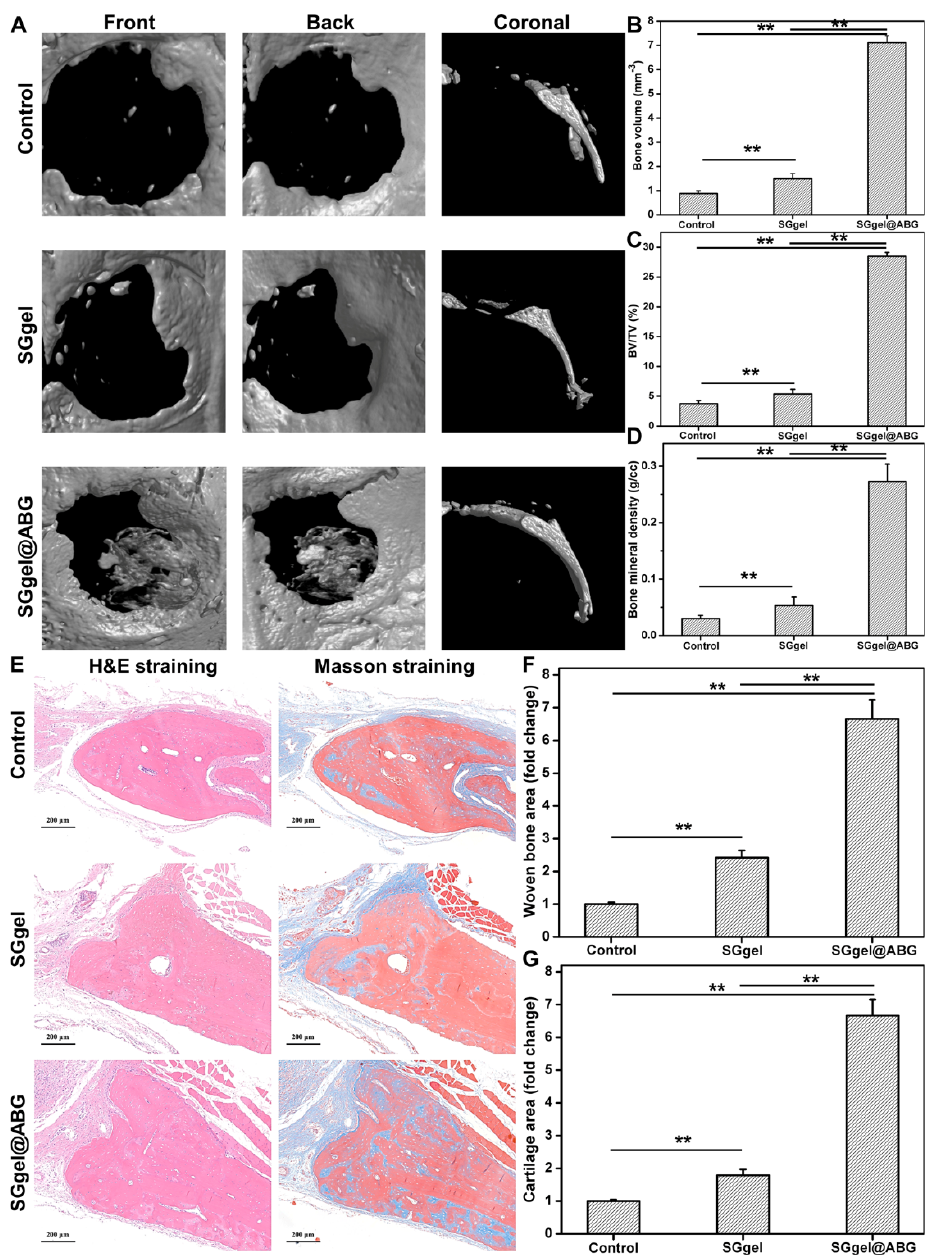
Figure 5. ( A ) 3D reconstruction of Micro-CT images of regenerated bone formation in rat cranium after the hydrogel implantation for 8 weeks with control group, SGgel group and SGgel@ABG group. ( B – D ) Quantitative analysis of BV, BV/TV and BMD of newly formed bone tissue. ( E ) H&E and Masson’s trichrome staining. ( F , G ) Woven bone and cartilage areas were analyzed in defect bone region. * p < 0.05, ** p < 0.01.